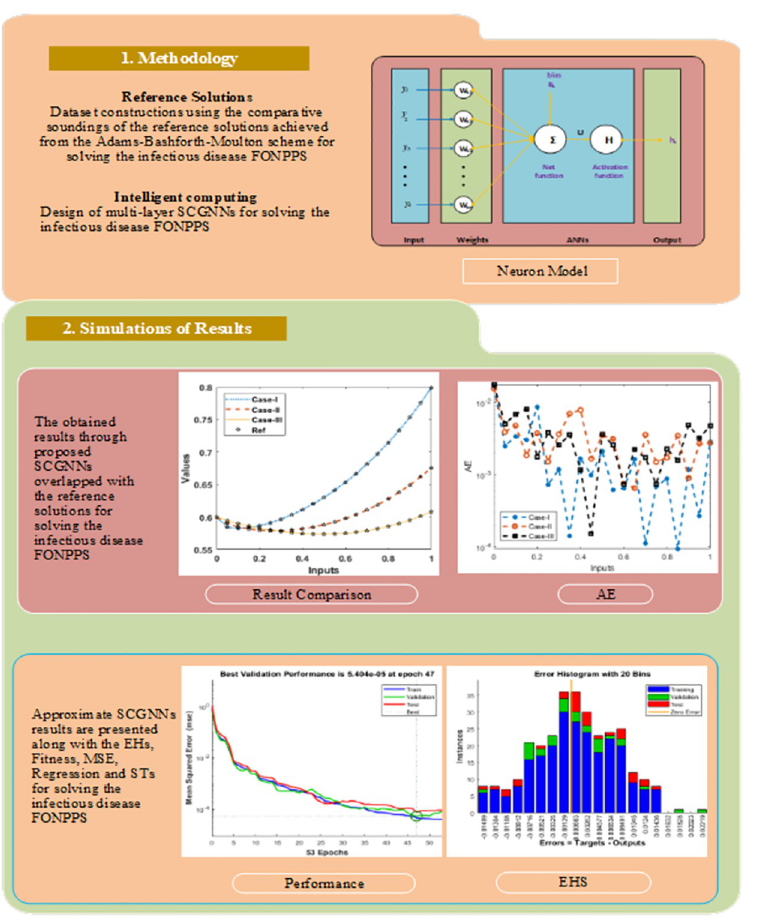
Fig 1. Workflow diagram of the proposed SCGNNs for solving the infection FONPPS.